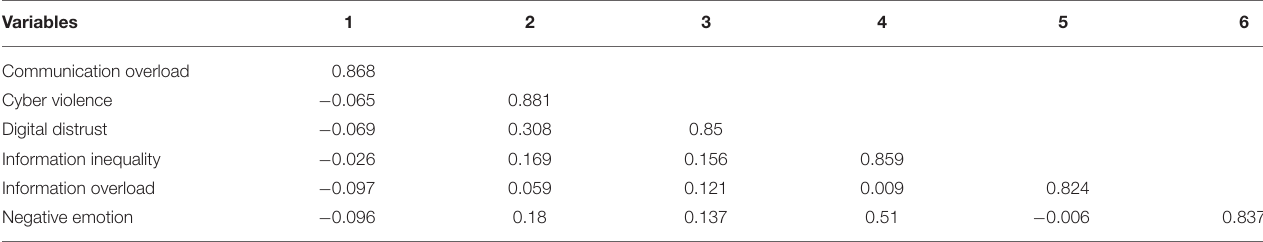
TABLE 4 | Discriminant